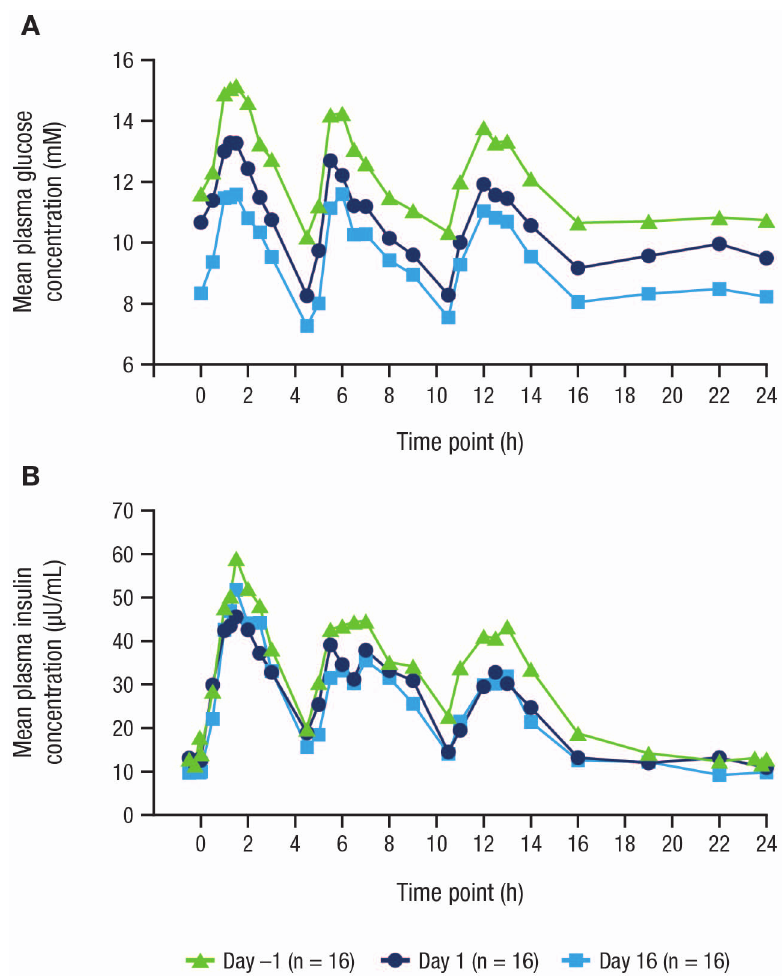
Figure 5. Mean (A) PG and (B) plasma insulin levels before (Day –1) and after a single dose (Day 1) and after multiple doses (Day 16) of canagliflozin 100 mg QD. PG, plasma glucose; QD, once